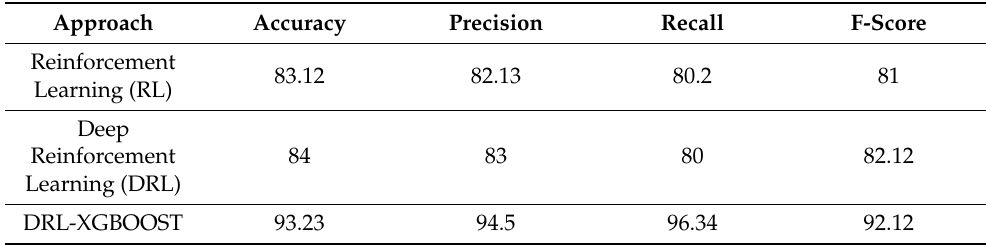
Table 7. ADNI dataset